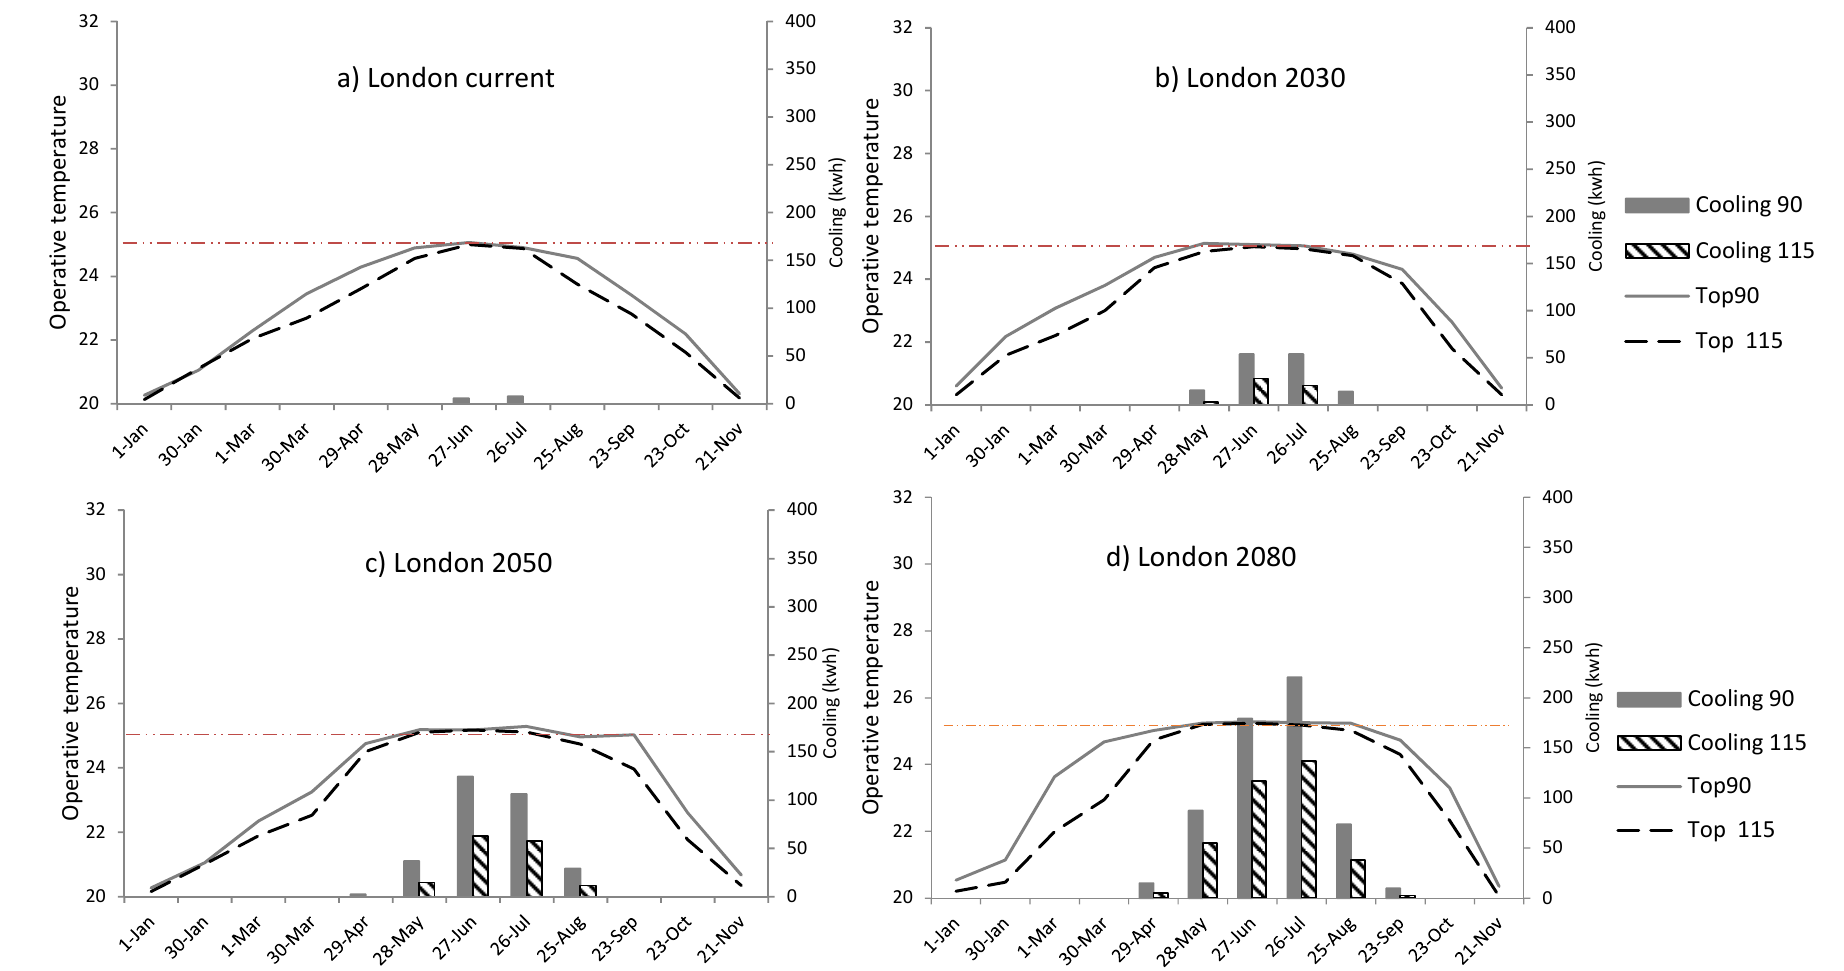
Figure 9. Monthly cooling required for the unit with vertical and tilted facade under four climatic